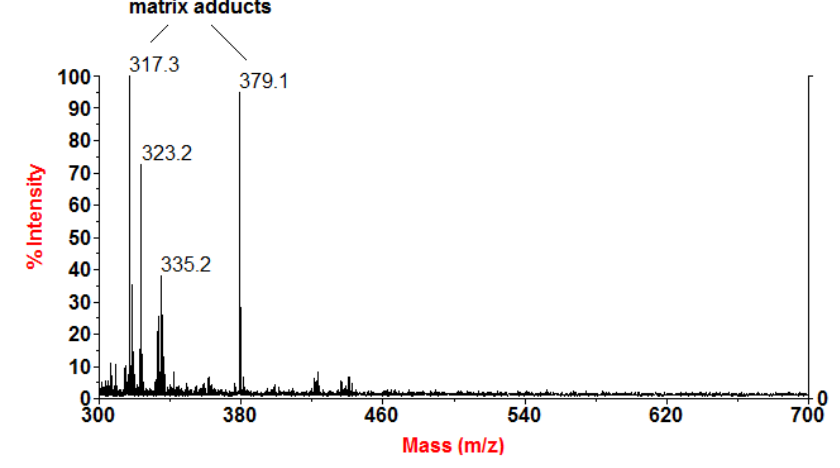
carboxylate sodium 18:3